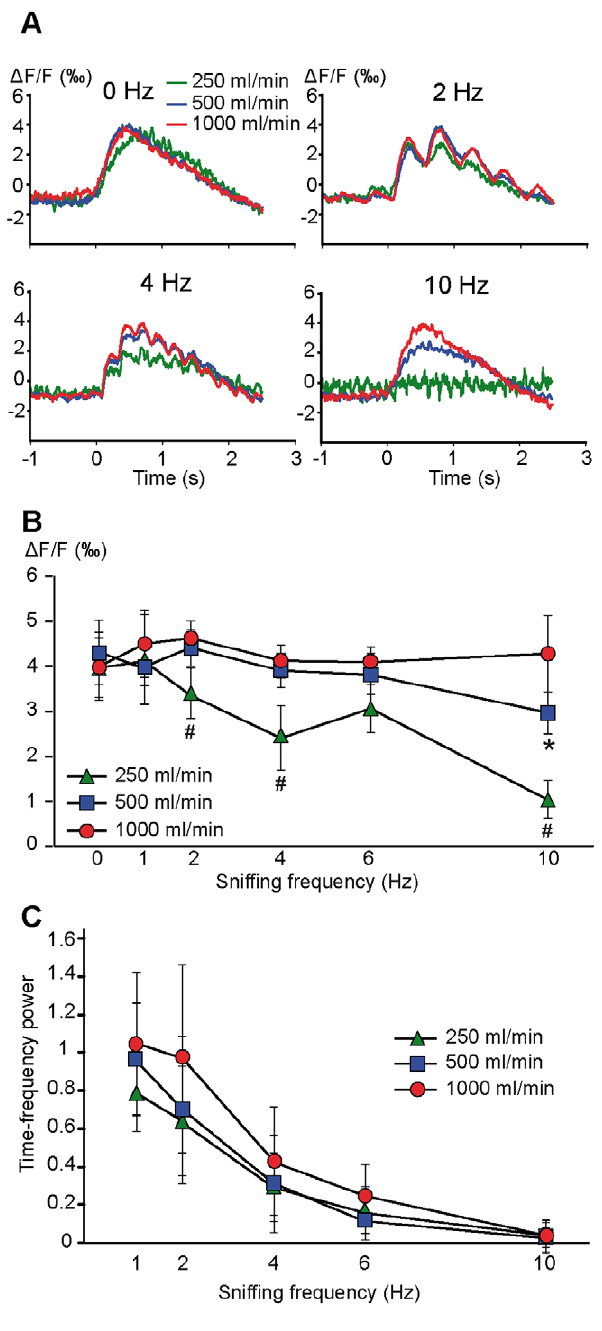
Figure 5. Concomitant effect of sniffing frequency and flow rate. A: Mean optical response as a function of sniffing frequency and flow rate. B: Mean amplitude ( 6 SD) of the tonic component of the optical responses as a function of both flow rate and frequency. (*) and ( # ) indicate that the amplitude of the tonic response was significantly different for 500 ml/min and 250 ml/min, respectively. C: Mean amplitude ( 6 SD) of the sampling-related modulation (phasic compo- nent amplitude) as a function of both sniffing frequency and flow